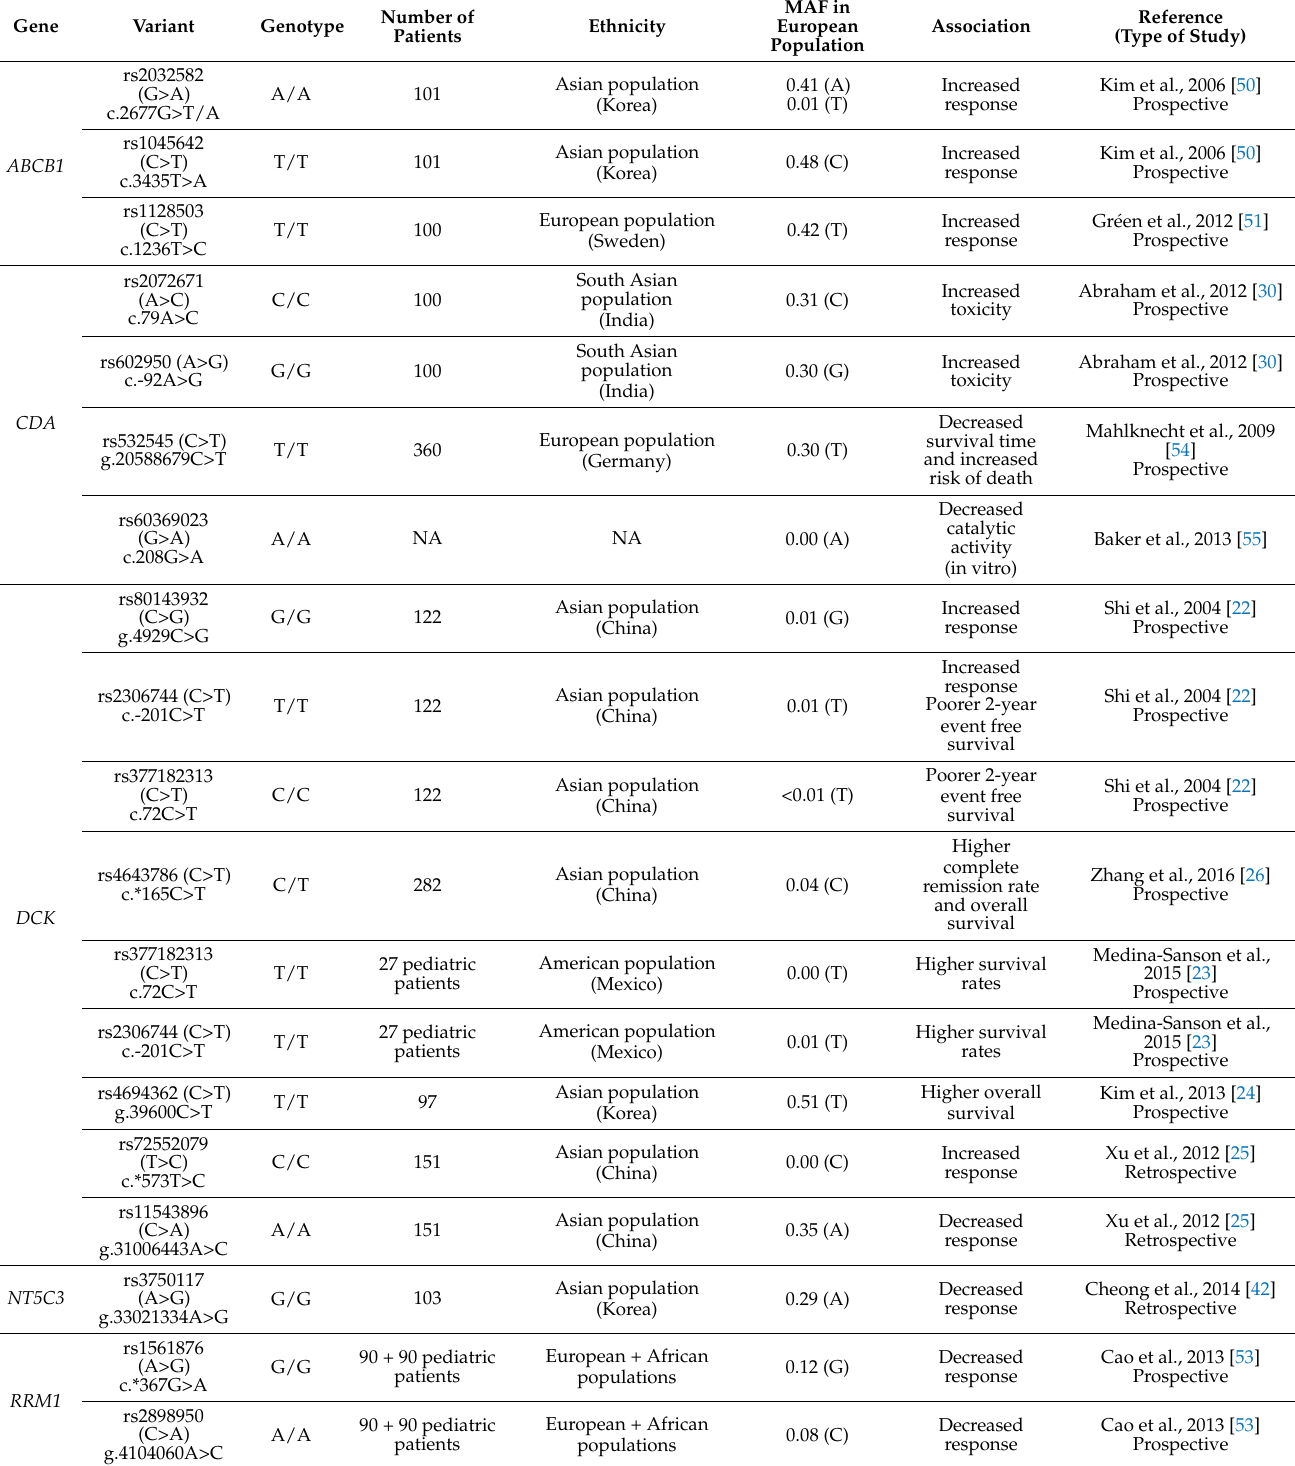
Table 1. Summary of the pharmacogenetic associations related to cytarabine response in AML